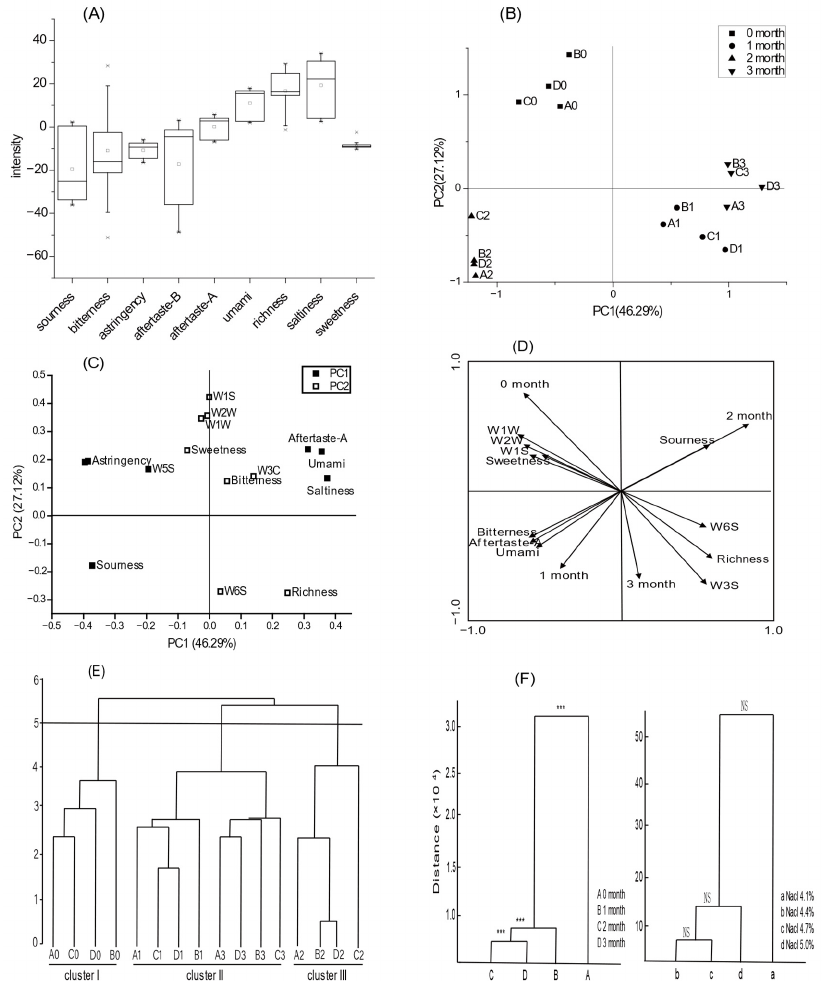
Figure 3. Comparative analysis on taste of hotpot sauces with different salt concentrations during storage. ( A ) Box plot of taste indicators. ( B ) PCA analysis of samples. ( C ) Factor score plot of samples. ( D ) Diplot of the RDA. ( E ) Cluster analysis on the sample quality. ( F ) Cluster analysis of sample quality with different storage time ( left ) and salt concentration ( right ). Note: In ( A ), “*” represented outliers, small square represented the average value. In ( B , E ), A–D indicated salt concentration of 4.1%, 4.4%, 4.7%, and 5.0%; 0–3 indicated storage time of 0, 1, 2, and 3 month. In ( F ), “***”